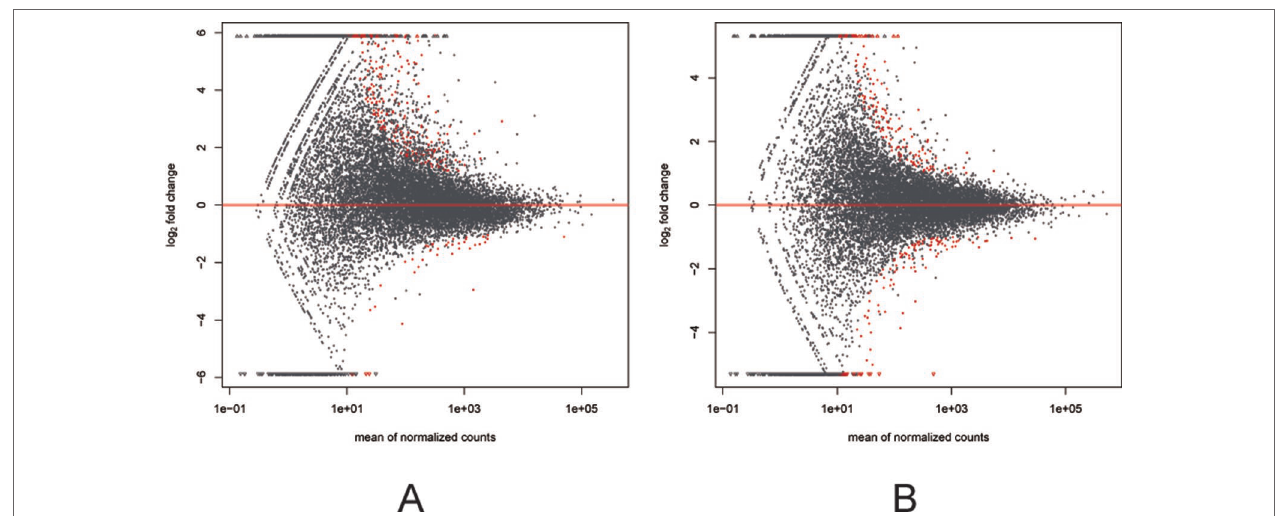
FIGURE 3 | MA plots (A and B) visualizing the differentially expressed genes (DEGs). The X-axis: Average expression of all samples for comparison after standardization; The Y-axis: log2FoldChange. The red dots represented the DEGs. The red dots above the red line: Up-regulated, below the red line: Down regulated. (A) the F1 generation DEGs: air-control versus hypoxia group. (B) The F2 generation DEGs: air-control versus hypoxia group.